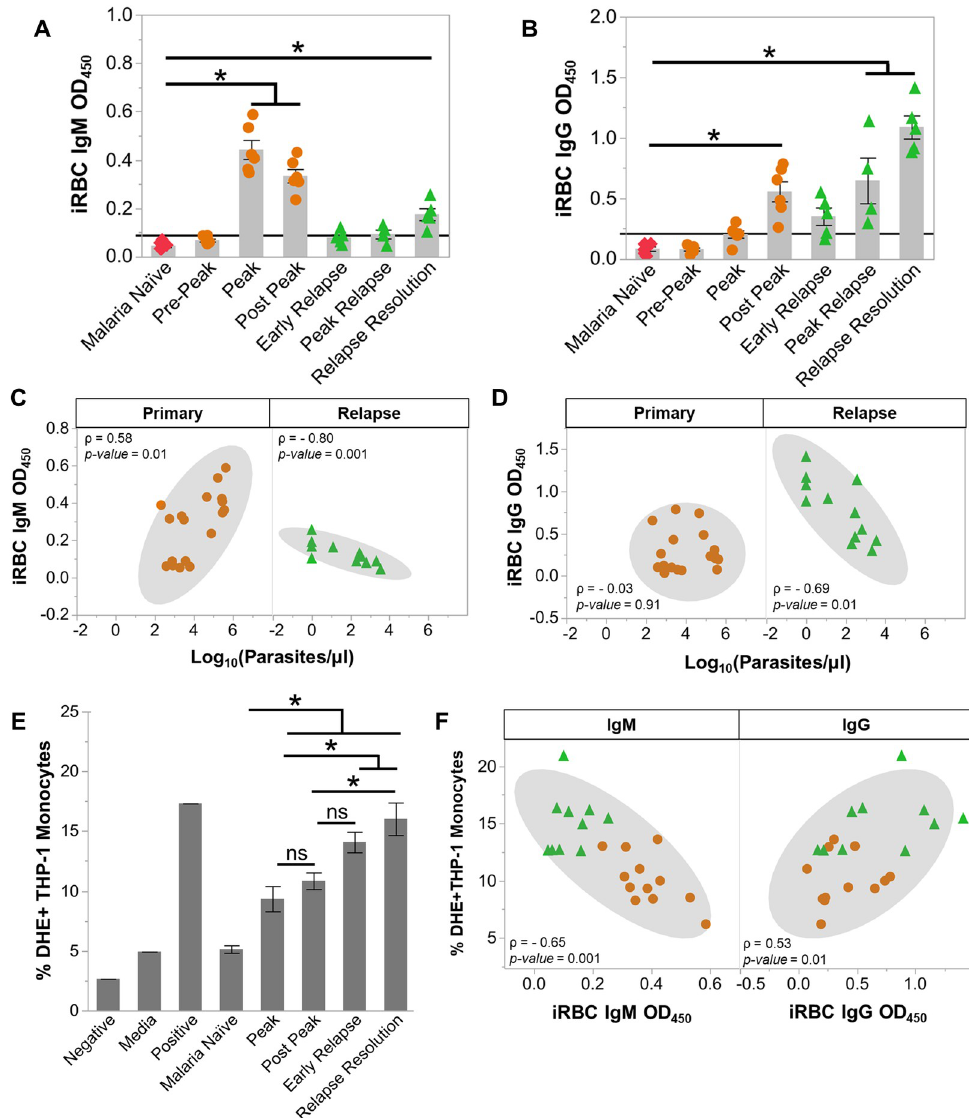
Fig 4. Anti-parasite IgG1 is produced rapidly during relapses and opsonizes P . cynomolgi infected RBCs. Kinetics of anti-iRBC IgM (a) and anti-iRBC IgG (b) response during primary and relapses infections as determined by ELISA; the black line indicates background defined as the average of the malaria na ï ve time point plus three standard deviations. Spearman’s correlation analysis of anti-iRBC IgM (c) and anti-iRBC IgG (d) responses in relation to parasitemia during primary or relapse infections. (e) Percentage of THP-1 monocytes that phagocytosed P . cynomolgi M/B strain iRBCs after opsonization with heat-inactivated plasma collected at different infection points during initial infections and relapses. (f) Spearman’s correlation analysis of opsonic phagocytosis activity and anti-iRBC IgM and IgG during primary infections and relapses. Gray bars indicate the mean of the data points shown; Error Bars = SEM. Statistical significance was assessed by a linear mixed effect model using a Tukey-Kramer HSD post-hoc analysis. Asterisks indicate a p-value < 0.05. ρ = Spearman’s correlation coefficient. To determine the functionality of the antibodies generated during the primary and relapse infections with respect to clearance of iRBCs, we performed a phagocytosis assay using a THP- 1 monocyte cell line, as previously described [37]. The percentage of THP-1 monocytes that phagocytosed iRBCs after being opsonized with heat-inactivated plasma increased from